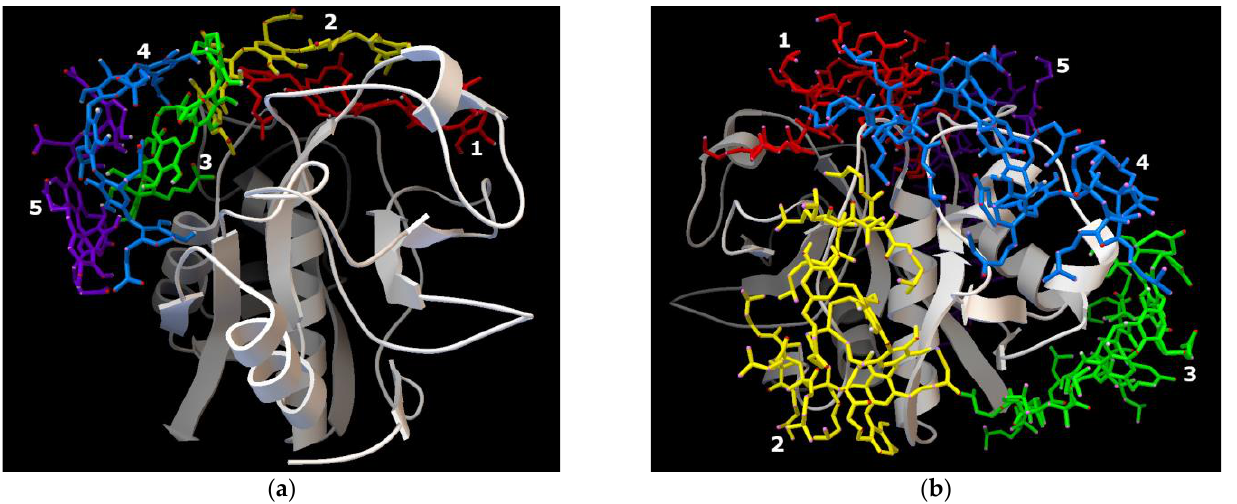
Figure 1. Molecular docking results. The topology of ficin complexes with Na-CMC ( a ) and Na-CMC- g -PDMAEMA ( b ).